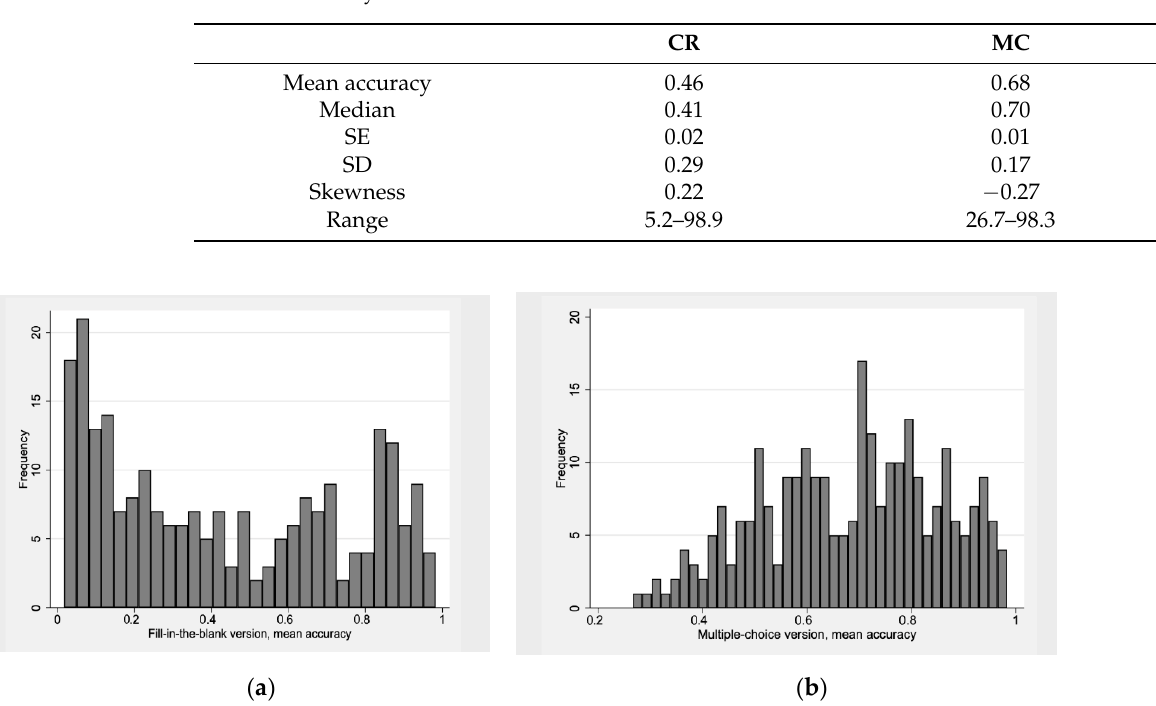
Figure 2. Frequency distribution of the cloze scores. ( a ) Fill-in-the-blank test; ( b ) multiple choice test.